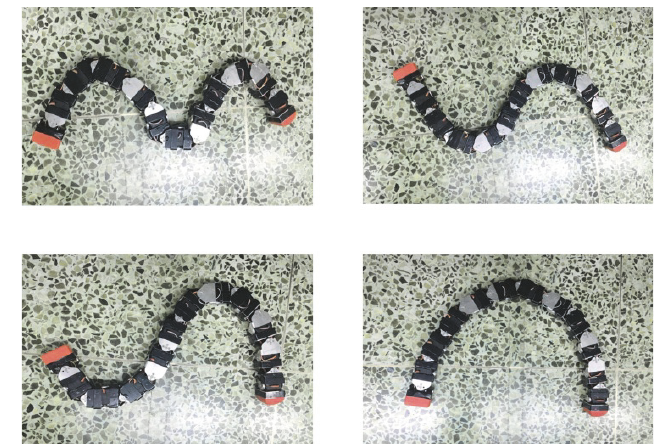
Figure 16: Different number of S-shape curve.